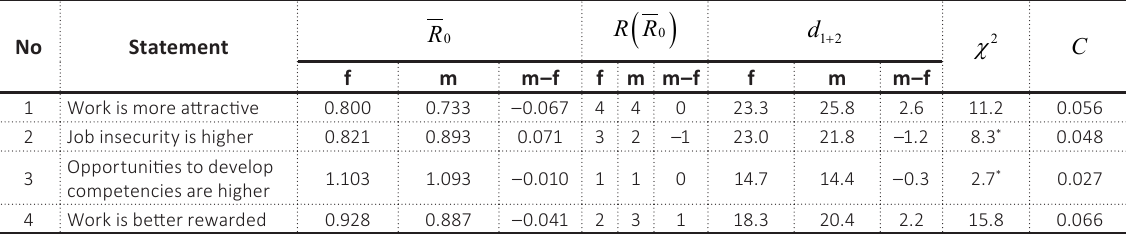
Table 3. Benefits of working in corporations as compared to family businesses